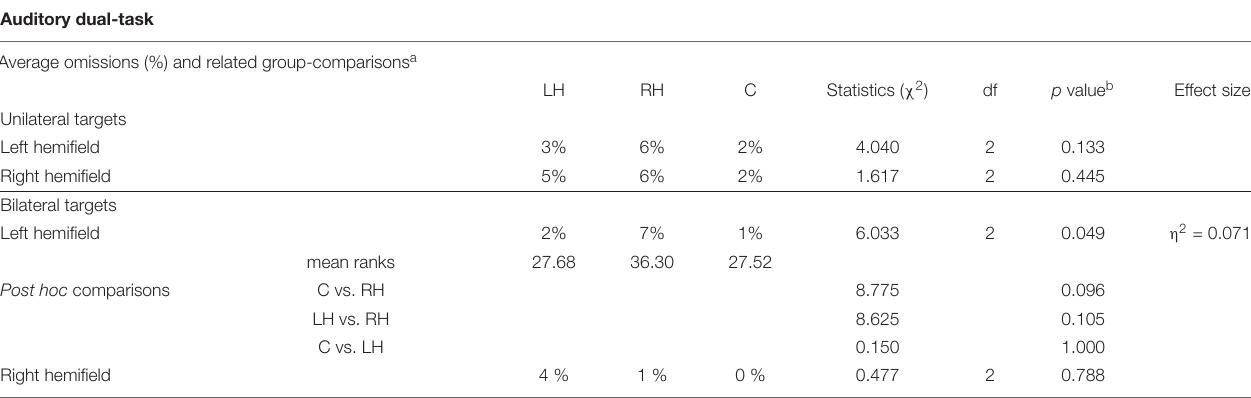
TABLE 7 | Average omissions in the Auditory dual-tasks, and related group comparisons, shown separately for unilateral/bilateral trials and for each hemifield. Auditory dual-task Average omissions (%) and related group-comparisons a